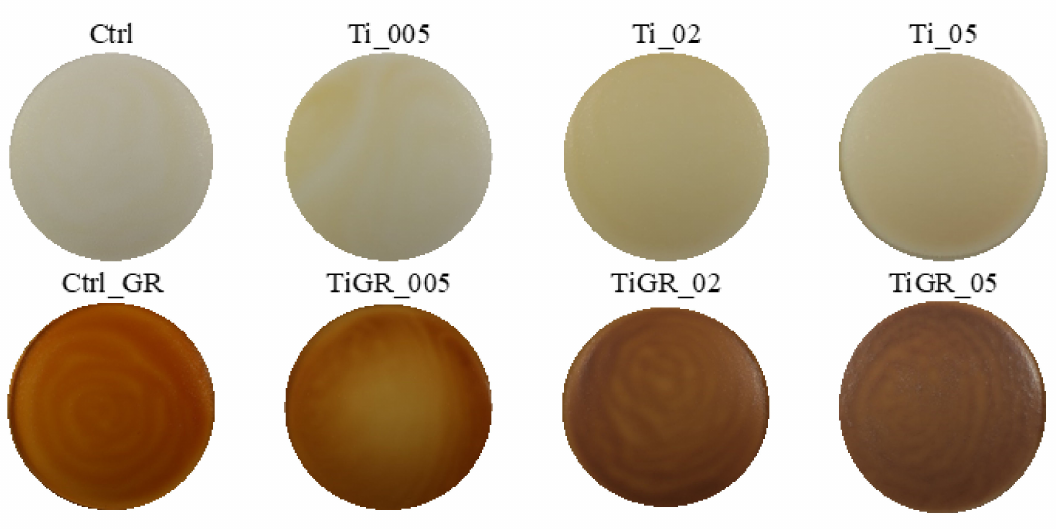
Figure 4. Digital images of edible coatings used for color analysis—samples with added TiO 2 nanoparticles.